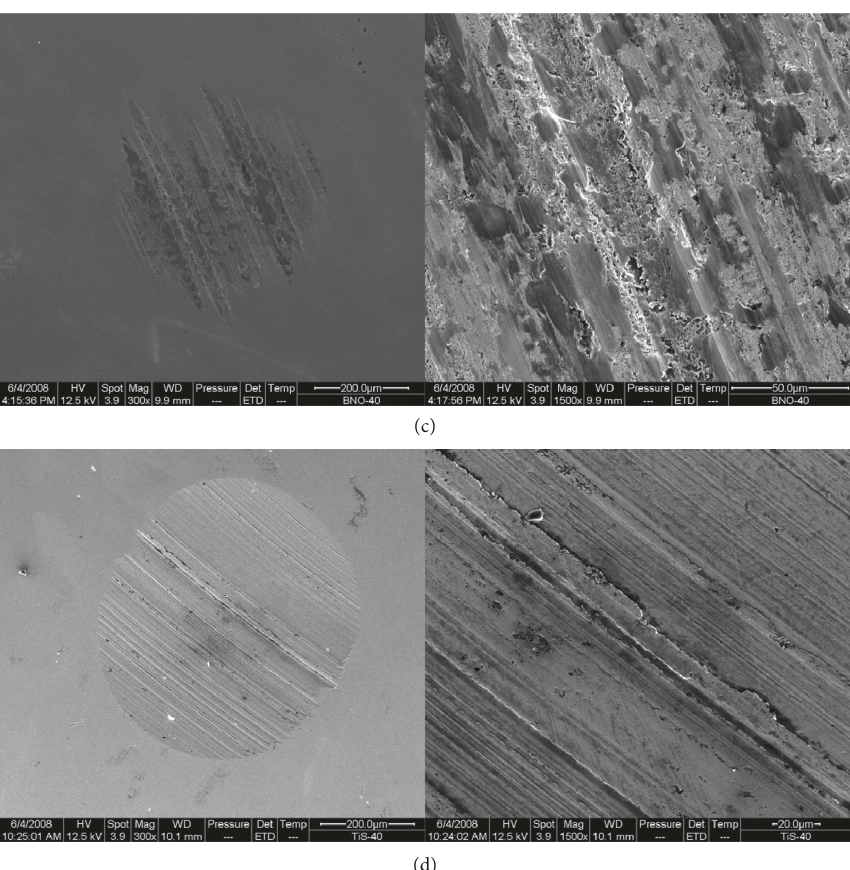
Figure 4: SEM photographs of worn scar lubricated with additive containing oil under different loads: (a) BNO with TiS at 392N; (b) BNO with TiS at 490N; (c) BNO at 490N; (d) TiS at 490 N. Table 6: Load-carrying capacities of BNO mixed with TiS.